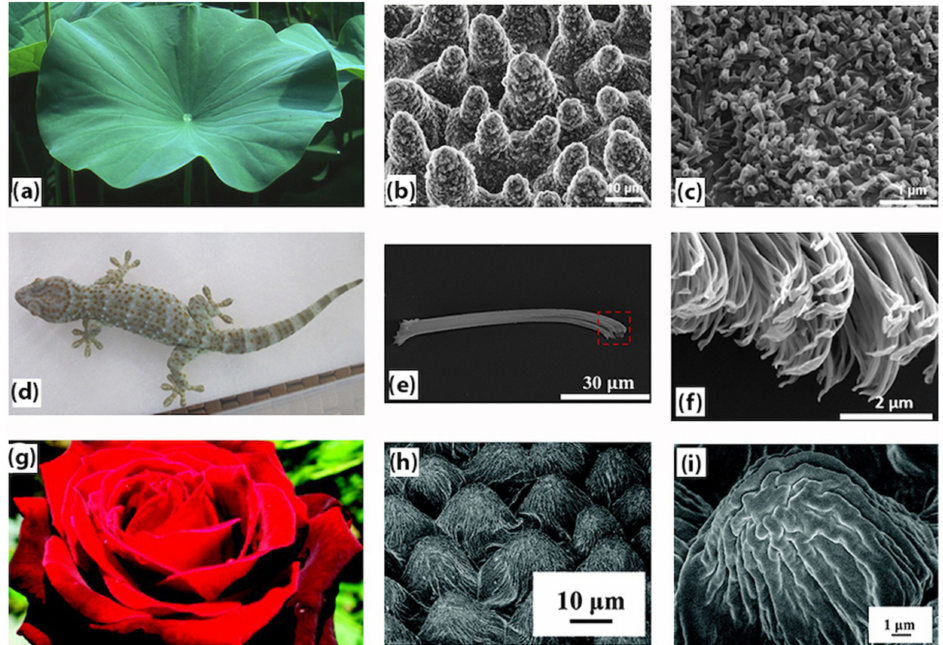
Figure 1. Images of various plants and animals showing their microscale and nanoscale structures: ( a ) image of a Lotus leaf; ( b ) scanning electron microscopy (SEM) image of the upper side of a Lotus leaf prepared by ‘glycerol substitution’ shows the hierarchical surface structure consisting of papillae, wax clusters and wax tubules; ( c ) wax tubules on the upper leaf side [6]; ( d ) image of a Tokay Gecko; ( e ) SEM image of a single seta; ( f ) SEM image of clusters of spatulae branching out the tip of a single seta (Reprinted from [7] with permission from Elsevier); ( g ) image of a red rose; and ( h , i ) SEM images of the surface of a red rose petal, showing a periodic array of micropapillae and nanofolds on each papillae top (Reprinted with permission from [8]. Copyright {2008} American Chemical